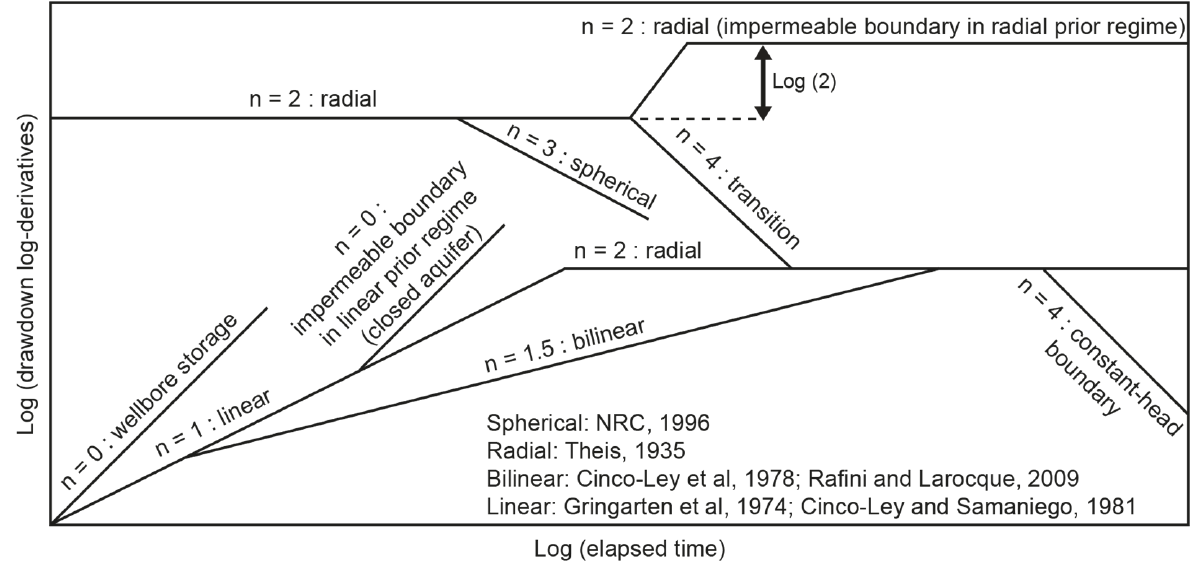
Figure 1. Summary of published theoretical flow regimes and their associated flow dimensions n in bi-log scale of dlogs / dt vs. time (redrawn from [12]).